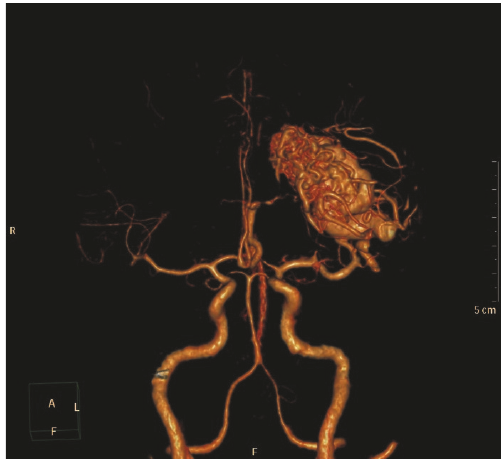
Figure 6: 3D cerebral CTA image showing an AVM with feeding artery arising from the left